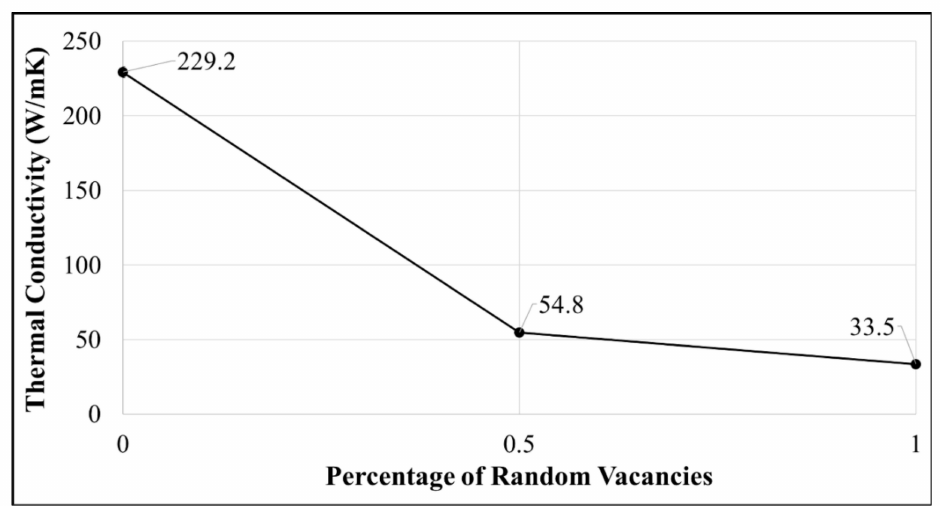
Figure 2. Variation in thermal conductivity of 3WCNTs with various vacancy concentrations. Each data point shows the average of a set of three simulations having three di ff erent patterns of (same) vacancy concentration.